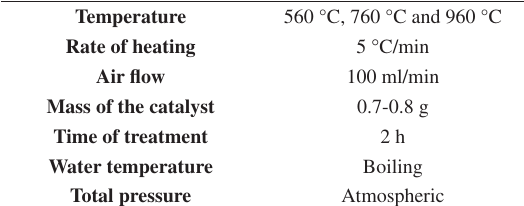
Table 1. Experimental conditions for hydrothermal